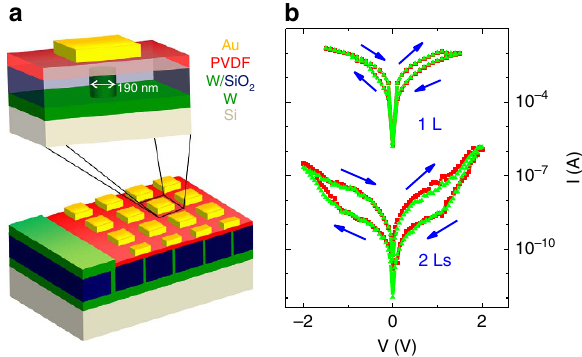
Figure 2 | TER in submicron Au/PVDF/W tunnel junctions. ( a ) Three- dimensional sketch of the design of PVDF ferroelectric tunnel junctions. ( b ) I – V curves in the 1 and 2Ls PVDF FTJs. The arrows show the direction of the voltage sweeps. The two different data colours are obtained on two different junctions for each